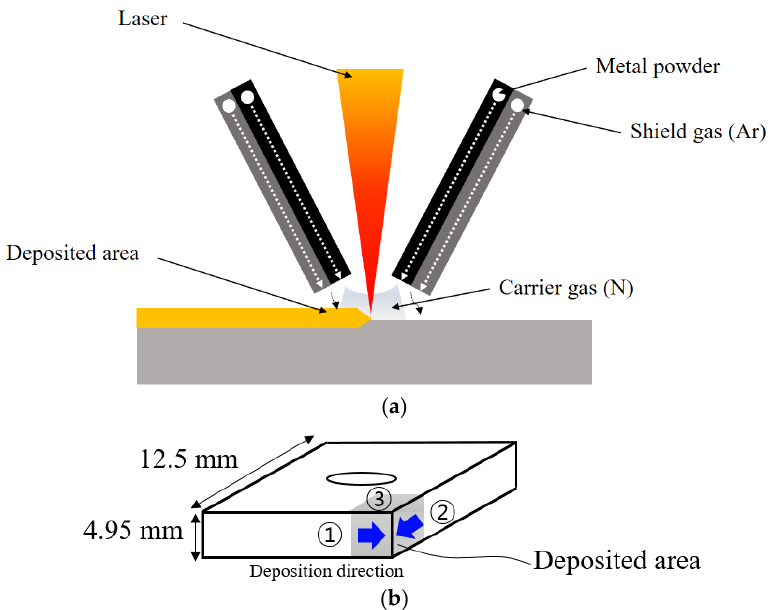
Figure 2. Schematic diagram of the direct energy deposition (DED) process ( a ) and titanium alloy powder deposited WC-Co cutting tool insert ( b ).